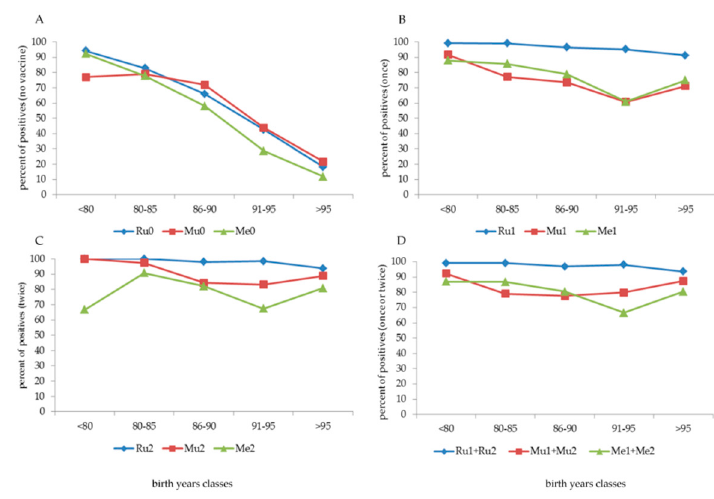
Figure 2. Percentage of positive antibodies against Ru, Mu and Ru in subjects who were not vaccinated ( panel A ) and those who were vaccinated with one ( panel B ), two ( panel C ) or one + two ( panel D ) doses according to date of birth classes.